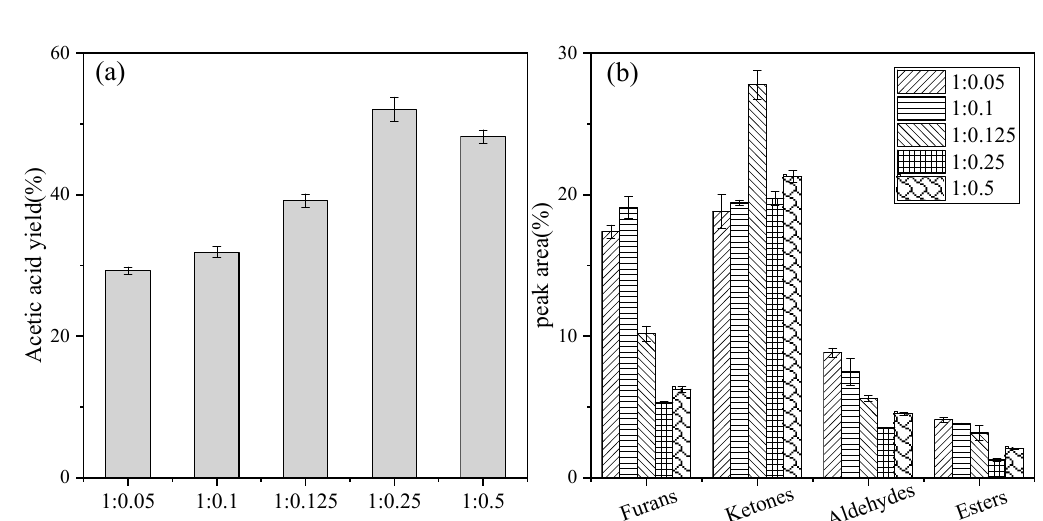
Figure 5. Comparison of the AA yields ( a ) and the product distributions ( b ) of the glucose in situ catalytic pyrolysis with a varying glucose / KAc ratio at 350 ◦ C for 30